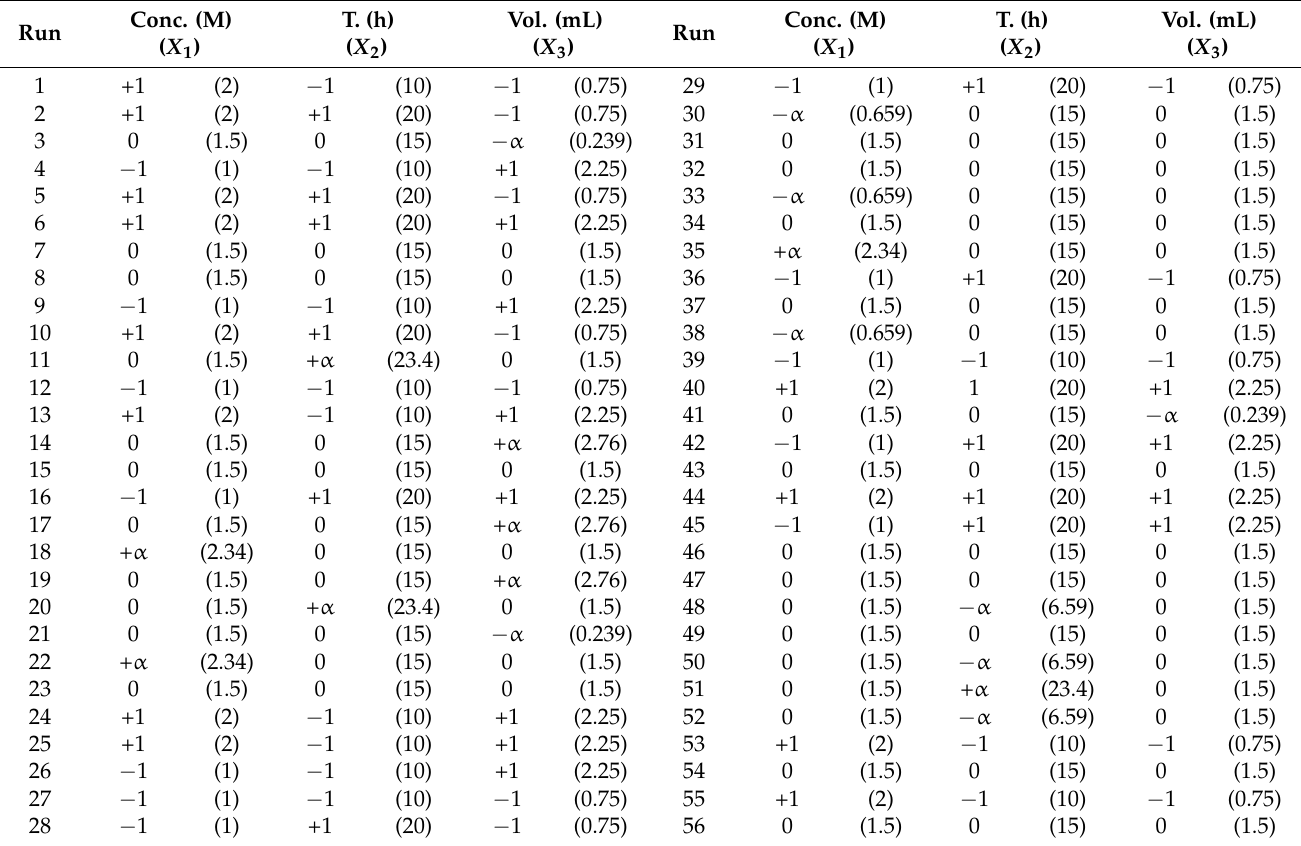
Table 1. Coded and natural values of central composite design (CCD) for the independent